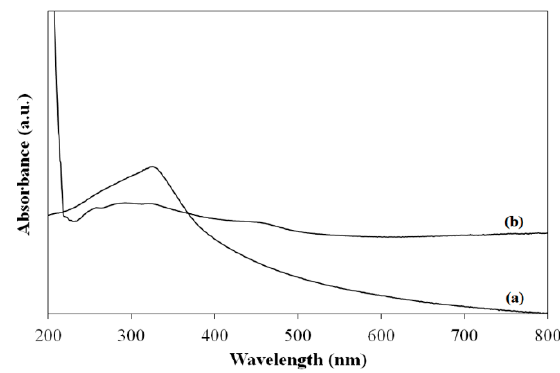
Figure 6. UV-Vis absorbance spectrum of ( a ) TiO 2 and ( b ) PVB/TiO 2 (10 wt.%).